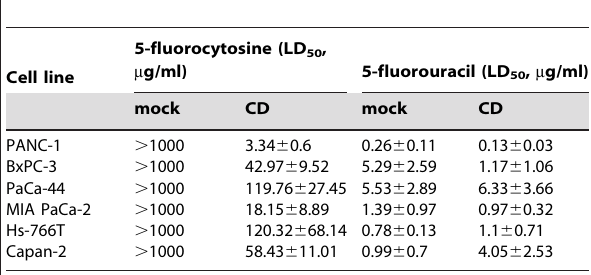
Table 3. Sensitivity of human pancreatic cancer cell lines towards 5-FC and 5-FU.